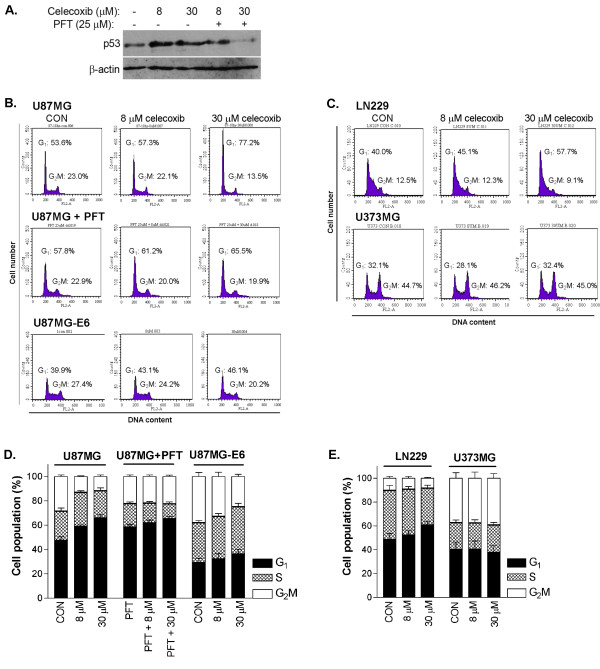
Effect of celecoxib on p53-dependent cell cycle progression. Cells were synchronised in serum-free medium for 48 hours and then treated with celecoxib (8 and 30 μM) in medium containing 10% FBS for 18 hours. In some cases, U87MG cells were pre-treated with PFT (25 μM) prior to celecoxib treatment. Cells were collected for protein extraction and cell cycle analysis. Following release of cells from starvation, the effect of celecoxib on p53 protein expression in U87MG and PFT-treated U87MG cells is shown (A). For cell cycle analysis, cells were fixed, stained with propidium iodide and analysed by flow cytometry. Representative histograms of cell cycle progression (B-C) and quantitative analysis of percentage gated cells at G1, S and G2M phases (D-E) are shown. All values are expressed as mean ± S.E.M, n = 5–8.